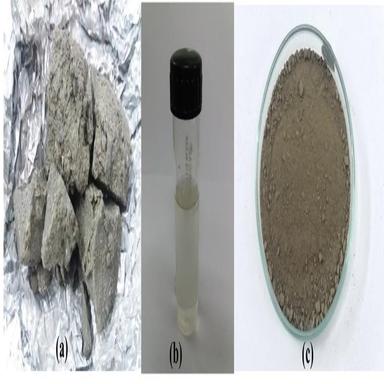
Representative forms of sediment samples (a) original sample recovered (b) and (c) Samples used for different characterization analysis.